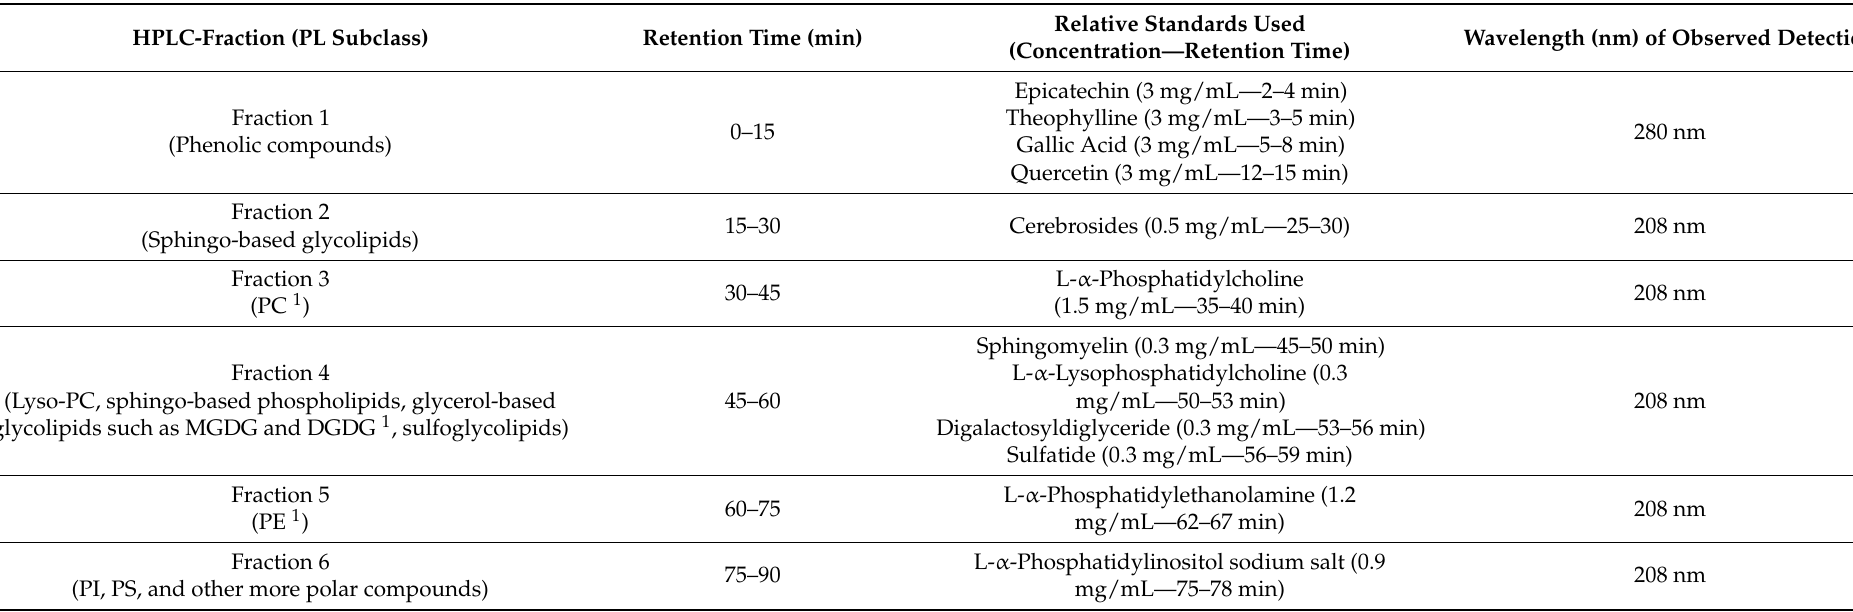
Table 2. Fractionation of the PL 1 extracts for each ACBP 1 into HPLC fractions/PL subclasses with relative retention times, according to specific